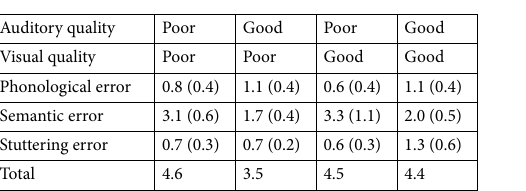
Table 1. Percentage of different error types out of all shadowed words by audiovisual (AV) quality (± SEM).